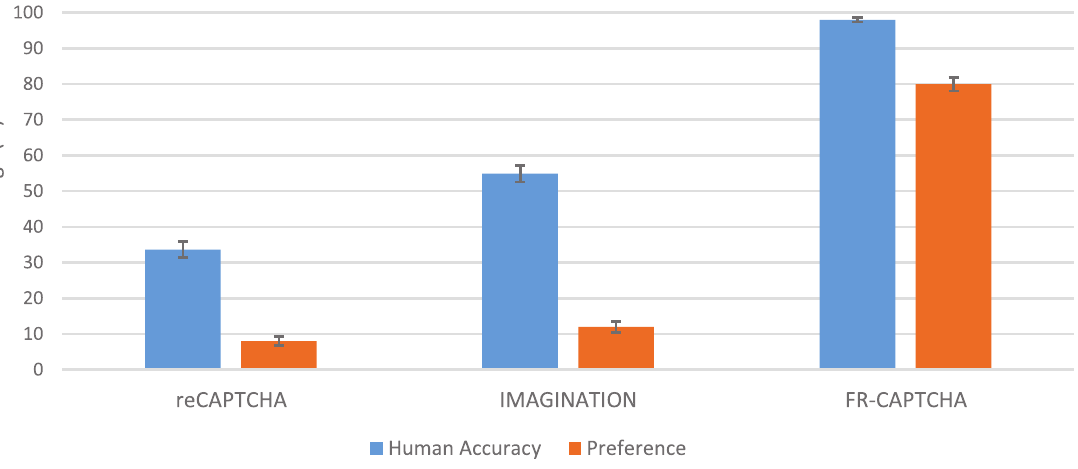
Figure 6. Human performance and preference on reCAPTCHA, IMAGINATION and the proposed FR- CAPTCHA. Based on 2,997 responses, the proposed CAPTCHA achieves higher human performance and is also preferred by majority (80%) of the users. The error bars